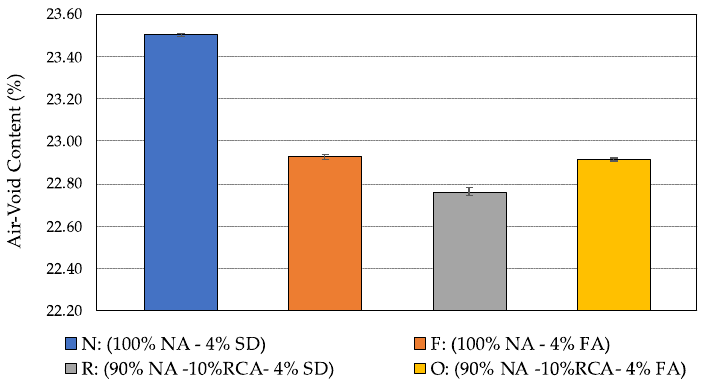
Figure 6. Average air-void content of the four porous asphalt mixtures.